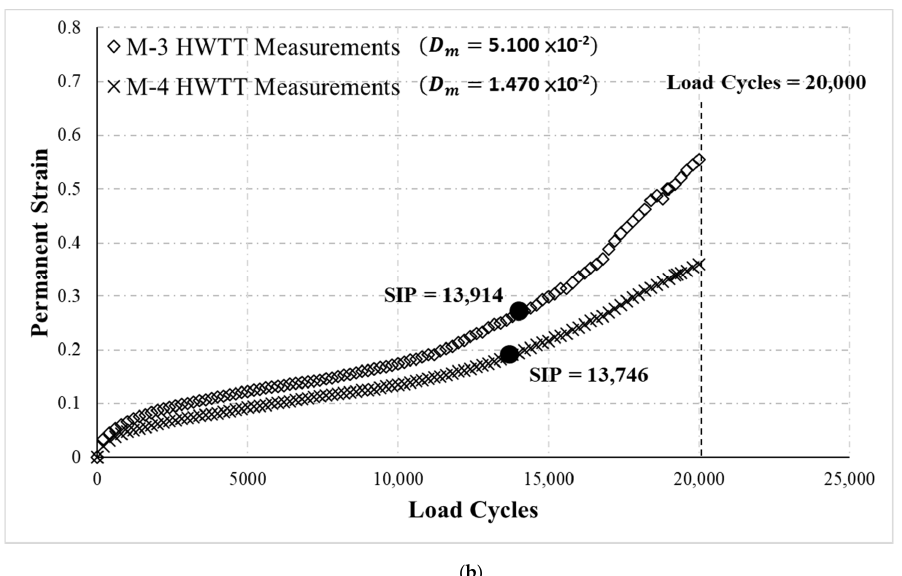
Figure 7. HWTT results for M-3 and M-4. ( a ) With a rut depth of 12.5 mm as the ending point of the data analysis. ( b ) With 20,000 load cycles as the ending point of the data analysis.